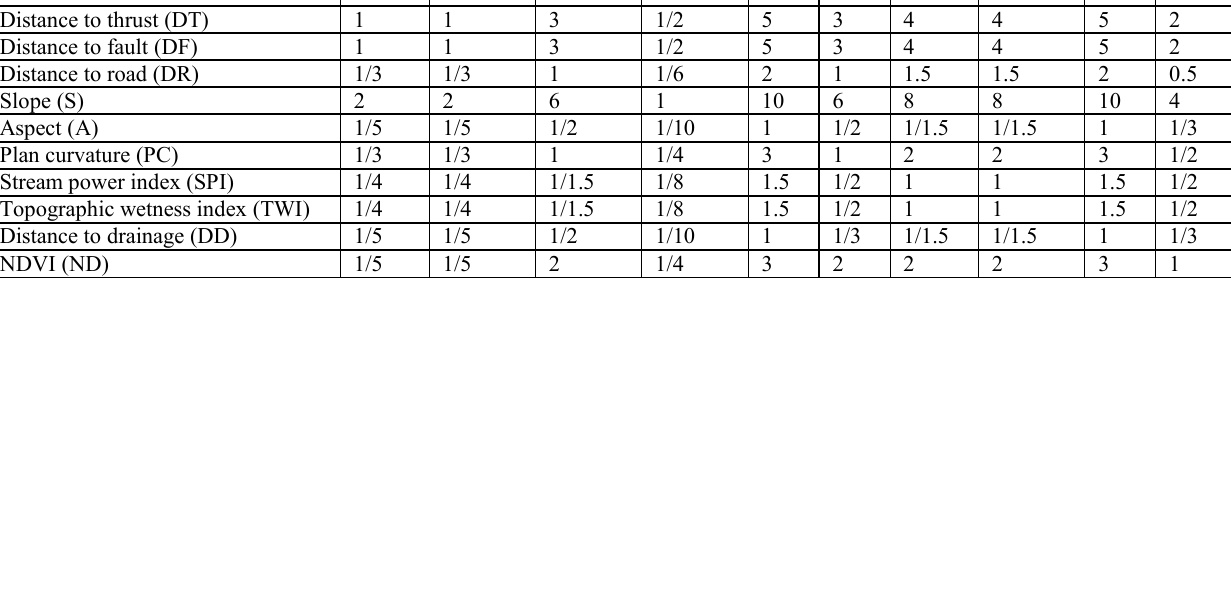
Table 3 Matrix showing the couple comparison of the factors for landslide vulnerability; AHP